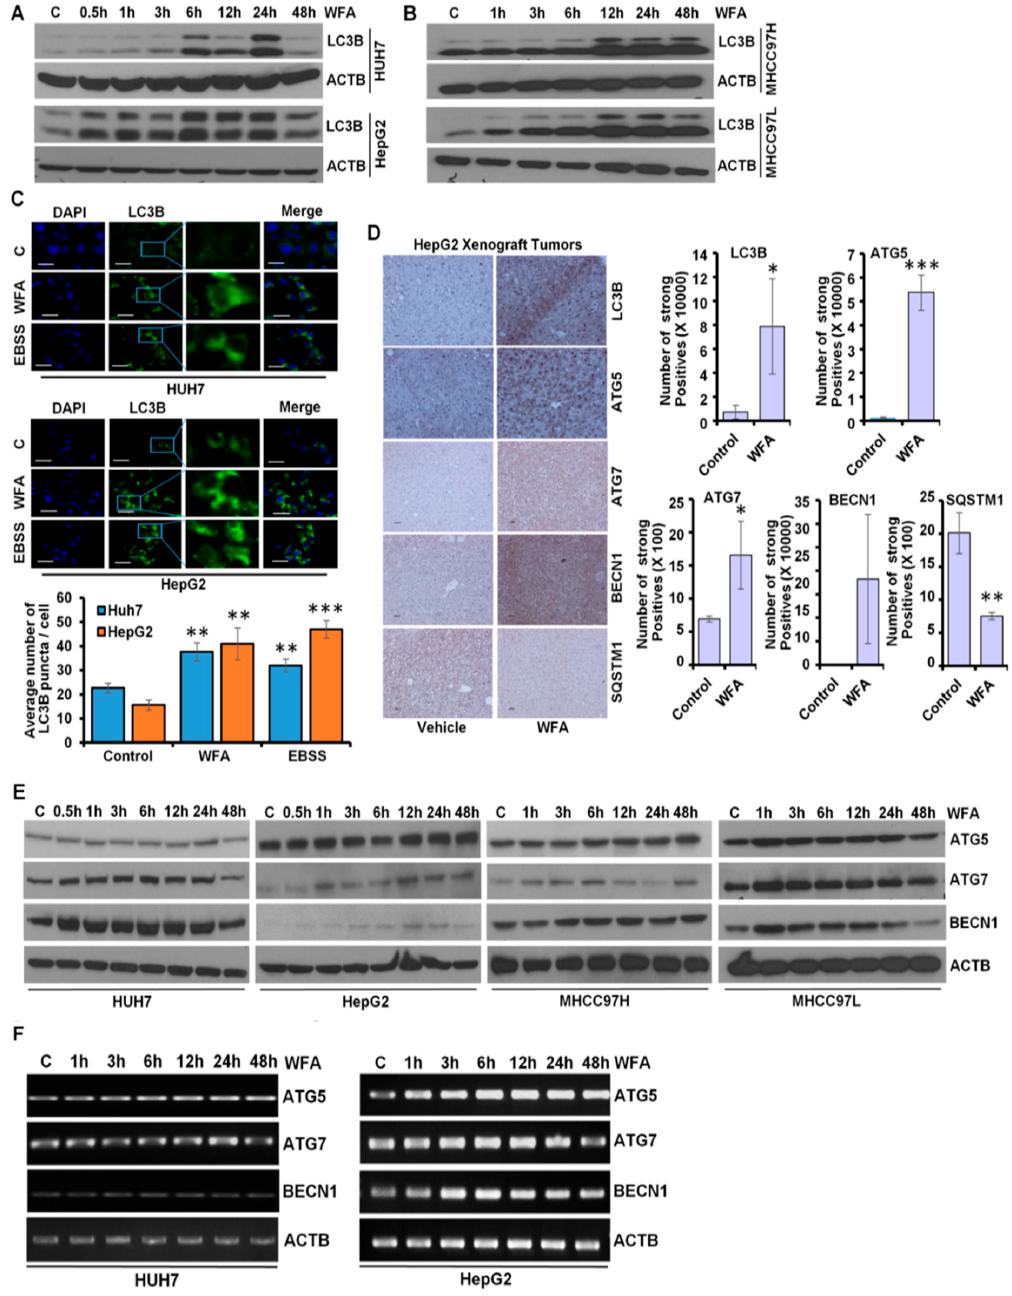
Figure 2. Withaferin A induces LC3B conversion and augments autophagy in vitro and in vivo. ( A , B ) Expression level of LC3B in HCC cells after treatment with 5 µ M of WFA by immunoblotting. ACTB served as the loading control. ( C ) HCC cells were transfected with a GFP-tagged LC3B-encoding plasmid, followed by treatment with 5 µ M WFA or EBSS. EBSS was used as a positive control for autophagy-induction. Representative images are shown. LC3B puncta were counted and shown as bar diagram. ** p < 0.01, compared with control; *** p < 0.001, compared with control. Scale bar 20 µ m. ( D ) HepG2 derived xenograft tumors from vehicle-treated and WFA-treated mice were subjected to immunohistochemical analysis for autophagy related proteins (LC3B, ATG5, ATG7, BECN1 and SQSTM1). IHC signals were quantified using Aperio ImageScope Software, Leica and shown as bar graphs. * p < 0.05, compared with control; ** p < 0.01, compared with control; *** p < 0.001, compared with control. Scale bar 100 µ m ( E ) HCC cells were treated with 5 µ M WFA and immunoblotted for